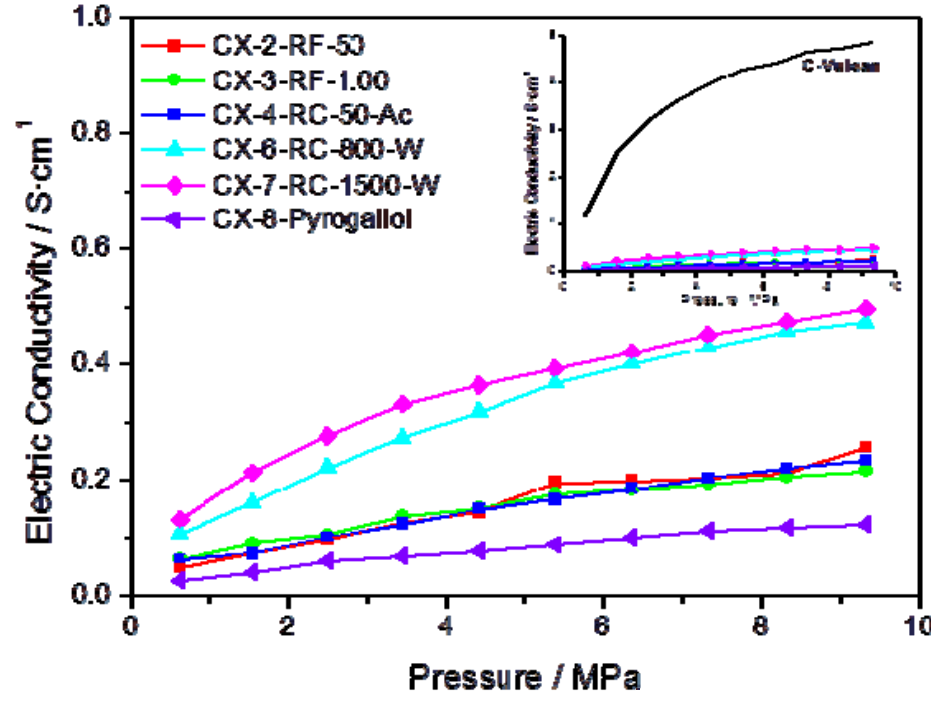
Figure 3. Electric conductivity vs . pressure for some of the prepared carbon xerogels; insert presents the conductivity of Vulcan carbon black as a function of the pressure, in comparison to the same series of carbon